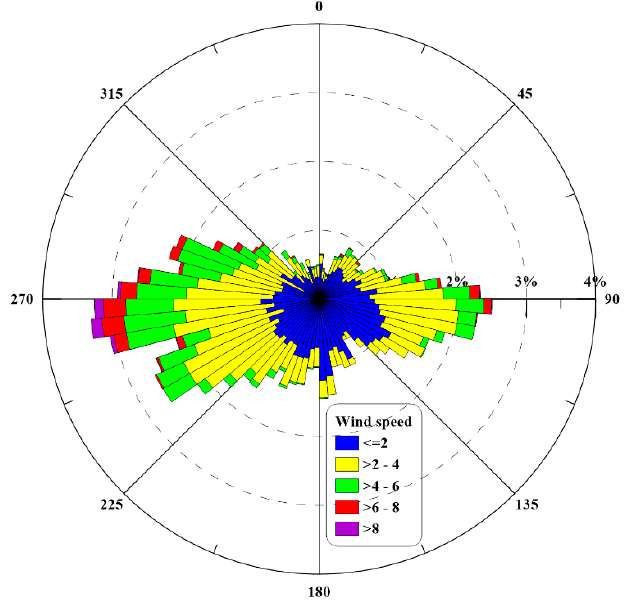
Figure 4. Wind rose chart. It shows the wind speeds and frequencies of different wind directions. The measurements of wind speed and direction were made at SL in 2014.